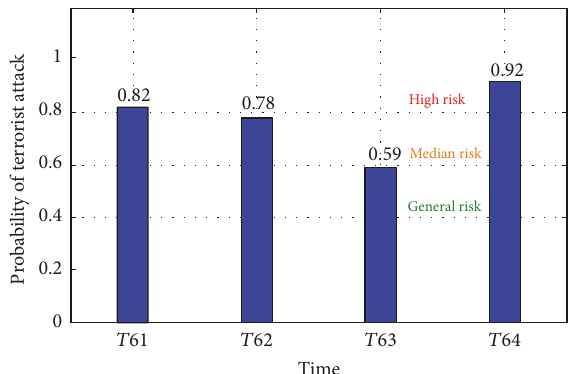
Figure 10: The risk of Attack behavior of the Al-Qaeda group in the subsequent